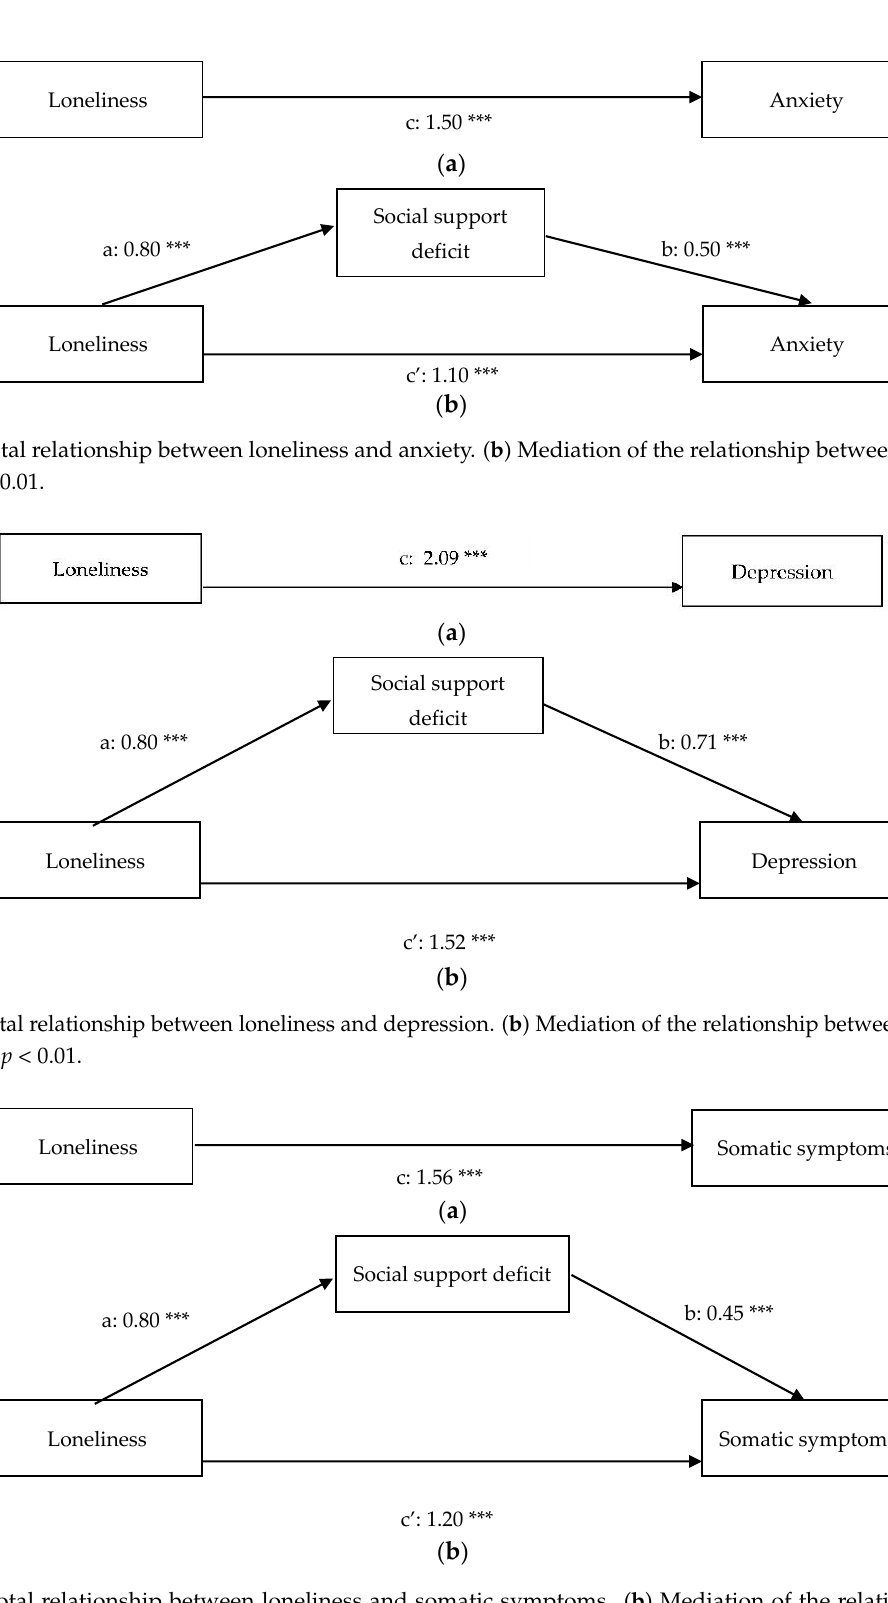
Figure 3. ( a ) Total relationship between loneliness and somatic symptoms. ( b ) Mediation of the relationship between loneliness and somatic symptoms. *** p <